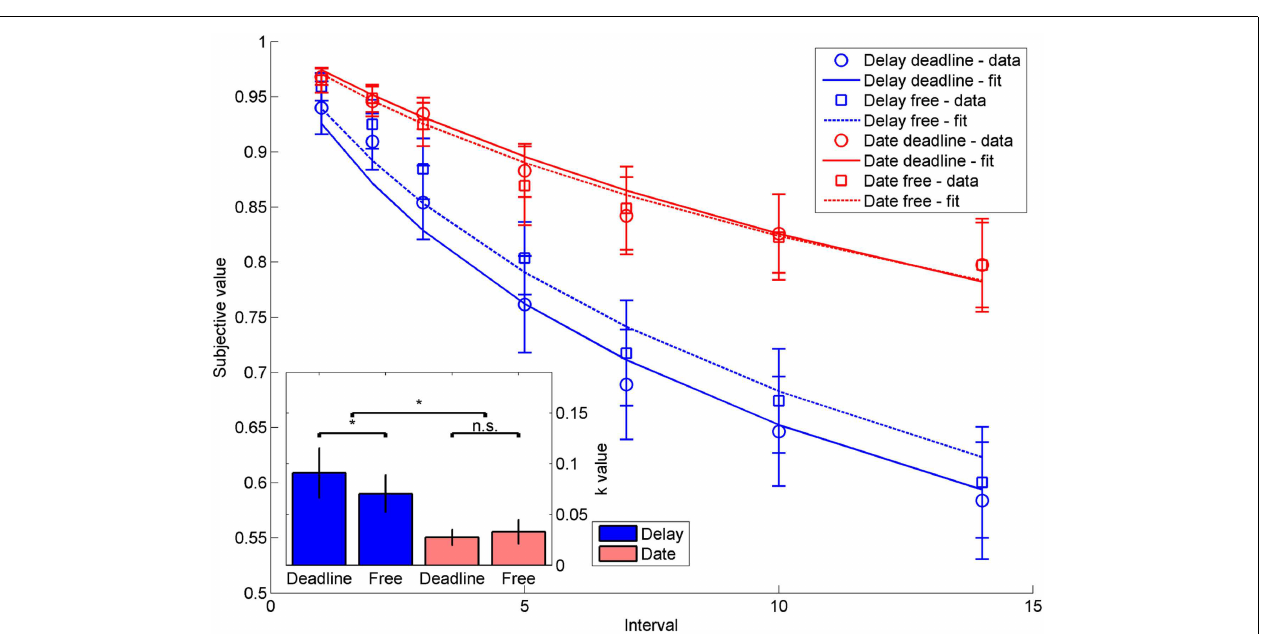
The inset shows the k -values of hyperbolic functions fit to the respective data. Stars mark statistical significance at p < 0.05, error bars indicate standard